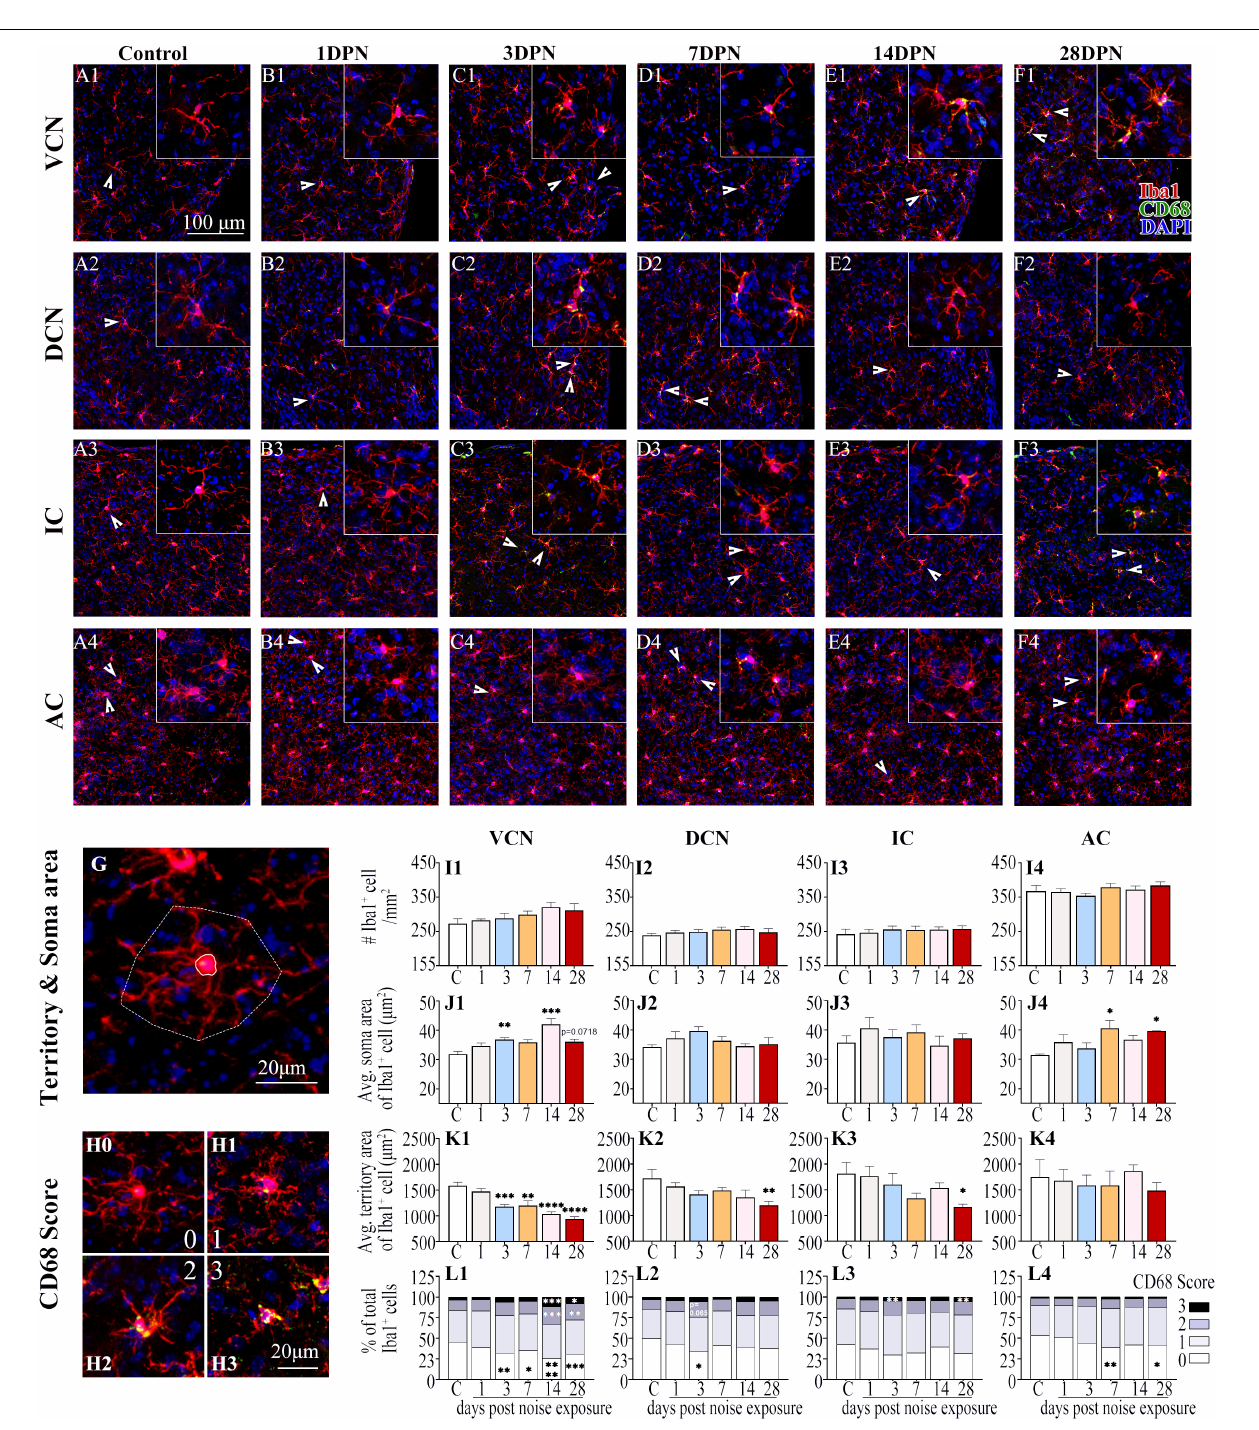
FIGURE 4 | Noise-exposed mice exhibited dynamic microglial alterations in auditory brain regions. (A1–F4) Representative images of Iba1 (red)-, CD68 (green)- and DAPI (blue)-stained brain sections of the control and noise-exposed mice. Scale bar: 100 µ m. The insets show higher magnifications of the corresponding microglia signified by arrowheads. (G) Soma area and territory area of microglia delineated by a solid (soma area) line and a dotted (territory area) line, respectively. (H0–H3) Representative images of the scoring of CD68 levels within Iba1 + cells. A score of 0 indicates no/scarce expression (H0) ; 1 signifies only patchy positivity (H1) ; 2 represents punctate expression roughly covering one-third to two-thirds of cells (H2) ; and 3 represents greater than two-thirds occupancy (H3) . (I1–L4) Quantification of the impact of NE on each individual parameter of microglia in the VCN, DCN, IC, and AC. The values are presented as the mean ± SEM of 3–6 mice per group. ∗ p < 0.05, ∗∗ p < 0.01, ∗∗∗ p < 0.001, ∗∗∗∗ p < 0.0001 in post hoc comparisons between the noise-exposed group and the control group following one-way ANOVA.